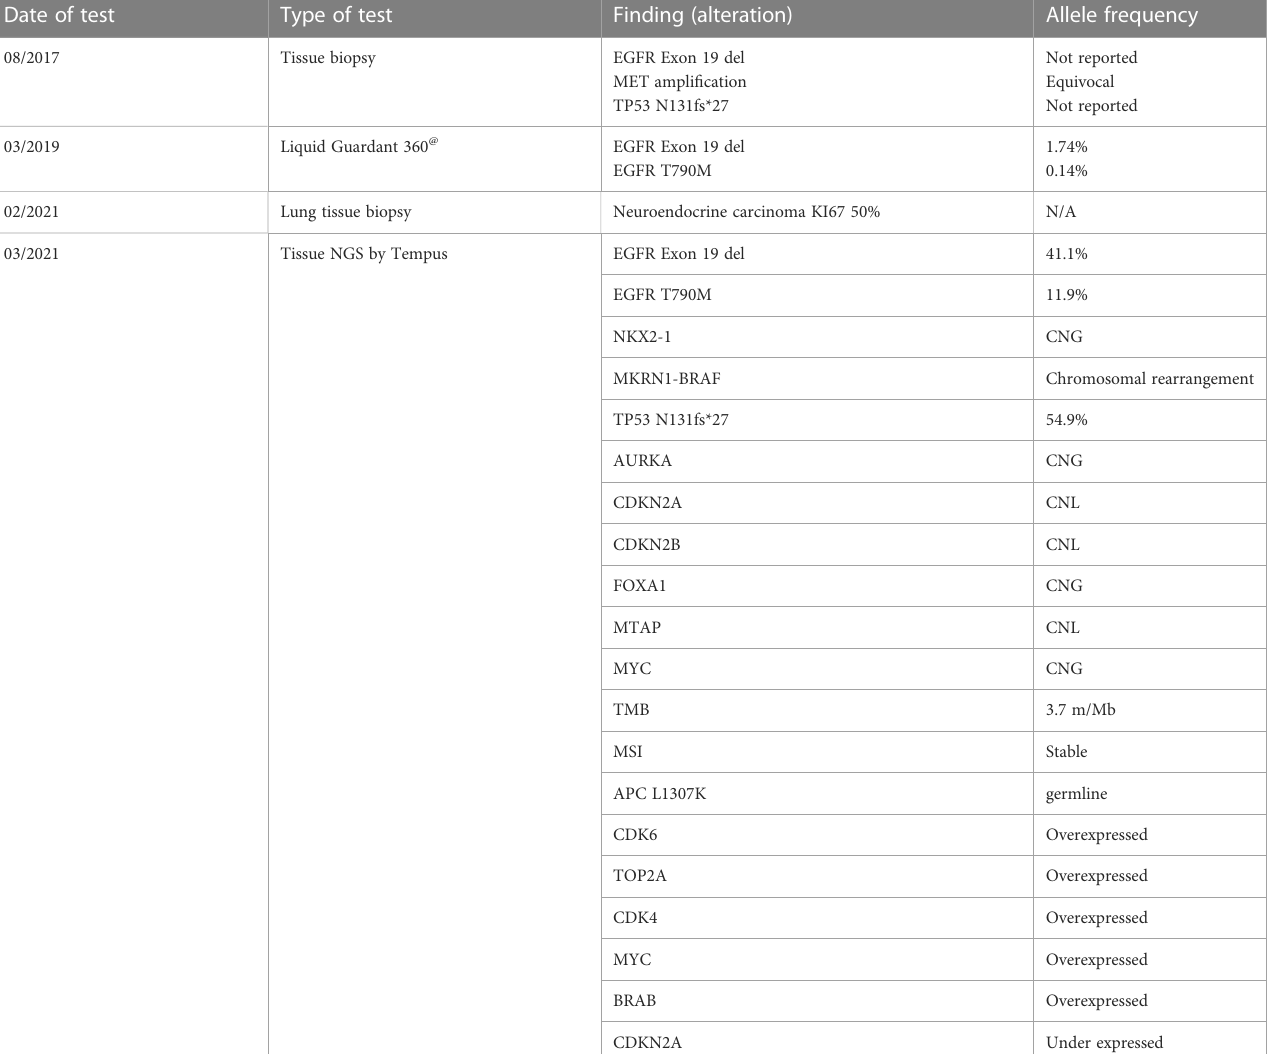
TABLE 2 Genes alteration detected throughout the treatment of the 2nd patient.